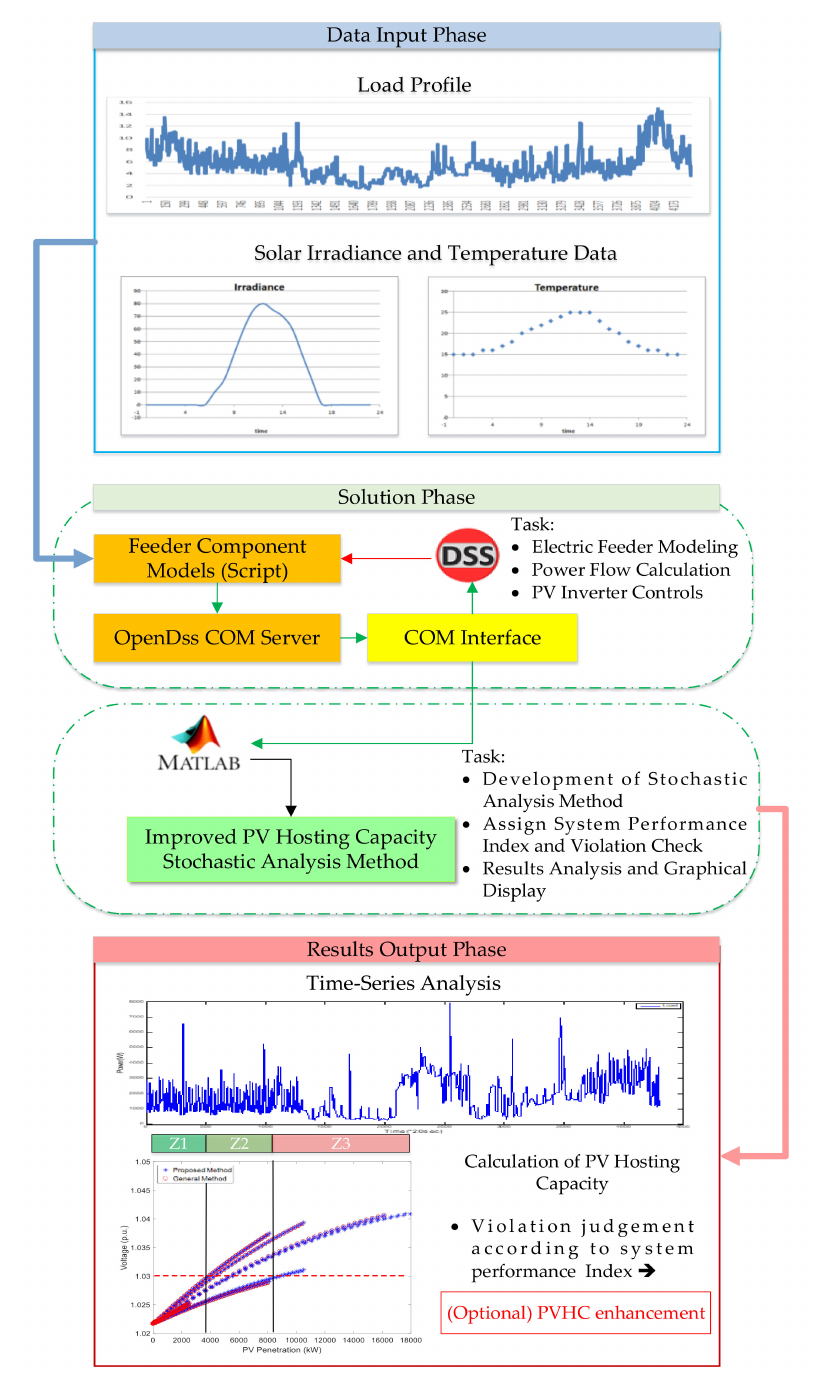
Figure 7. Implemented co-simulation mechanism in the